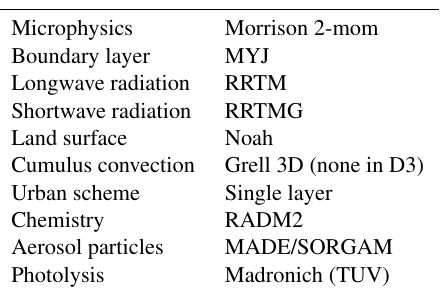
Table 2. Setting of physical and chemical schemes in the WRF- Chem